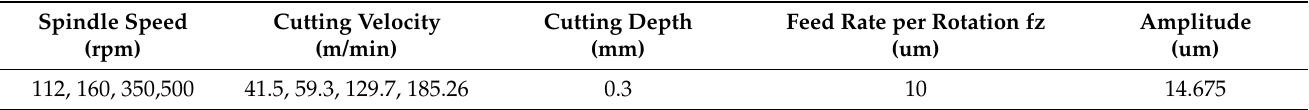
Table 3. Cutting parameters in UVC experiments.